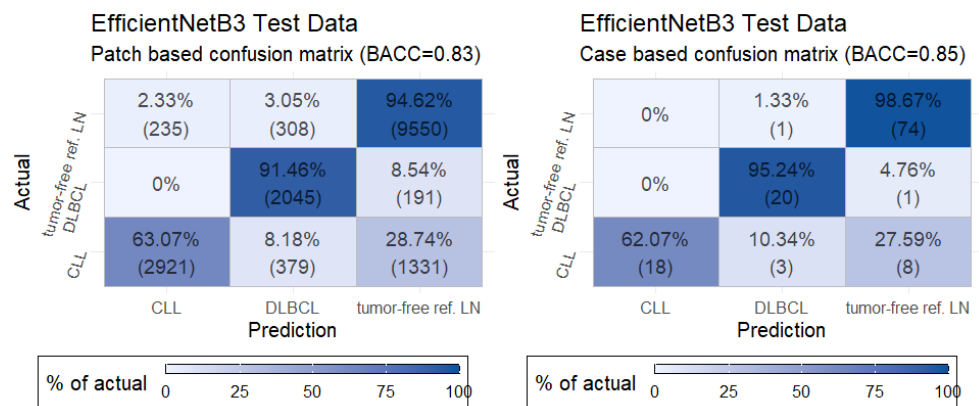
Figure 4. Confusion matrix of the best-performing model in terms of the test data at the patch ( left ) and case level ( right ). The lower panels exhibit the balanced accuracy (BACC). CLL: chronic lymphocytic leukemia, DLBCL: diffuse large B-cell lymphoma, LN: lymph node. Table 2 features the BACC for different quality control thresholds at the case or patch level. Any patch with a predicted probability (in terms of the highest prediction probability) of less than the patch-based quality control (PQC) threshold was filtered out. The case- based quality control (CQC) threshold filtered cases in which the proportion of patches for the predicted class was less than the threshold. From Table 2, one can see that an increase in the case-based quality control threshold improved the overall BACC up to 95.56%. A more detailed example for results with a PQC and CQC of 0.9 showed a decrease in the proportion of misclassified patches and cases (Figure S1). Only 3/102 patients were misclassified using high-quality control thresholds. Table 2. Balanced accuracy (BACC) given different case quality control (CQC) thresholds and patch quality control thresholds (PQC).